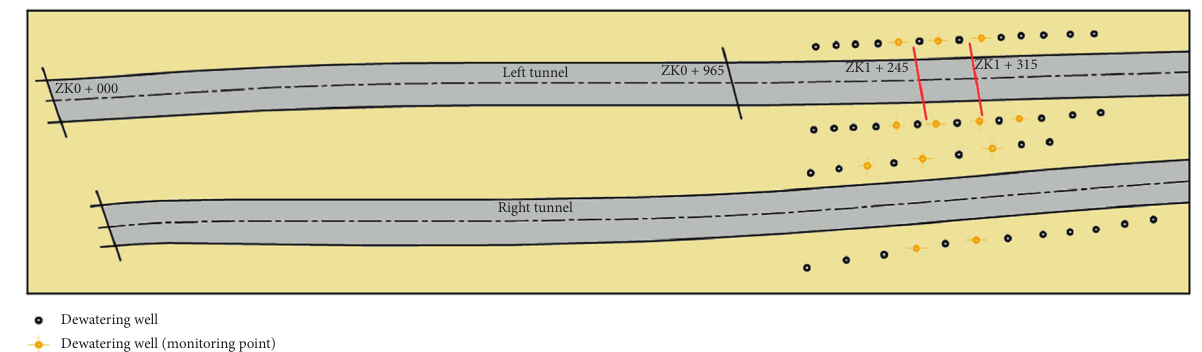
Figure 4: Plane layout of dewatering wells on